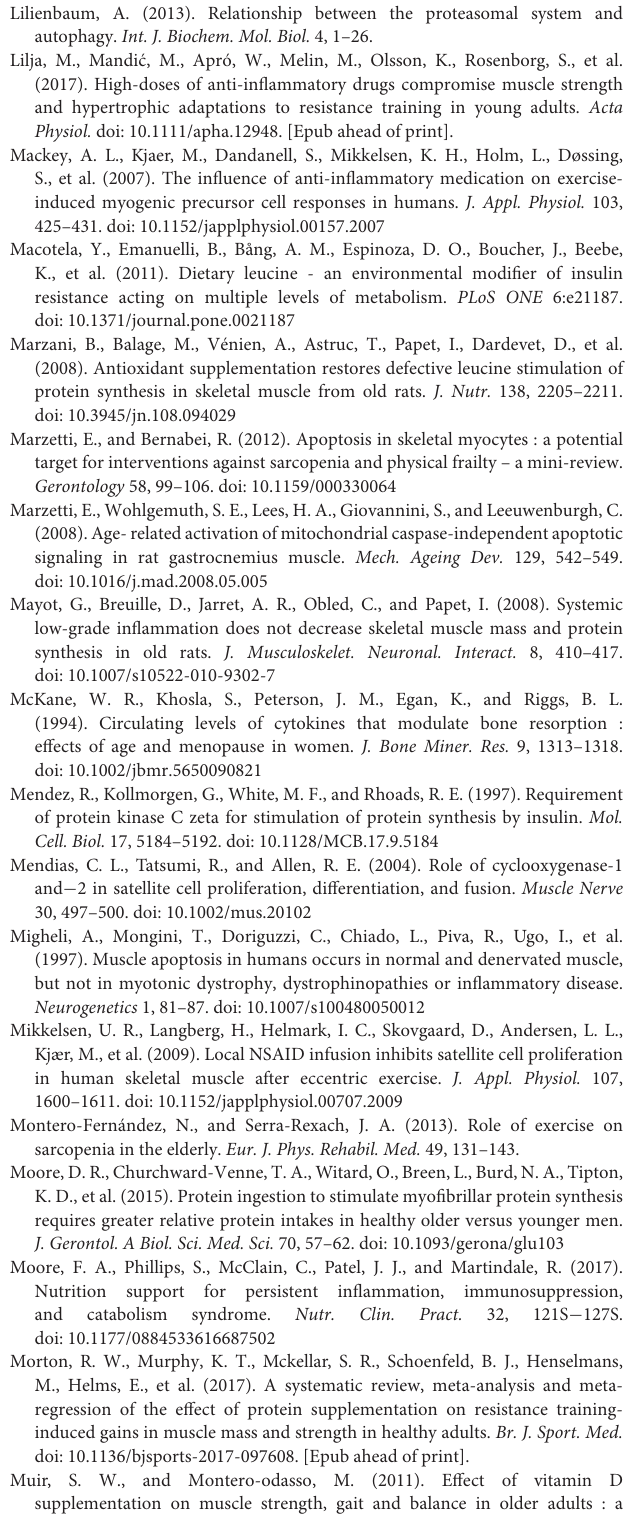
supplementation on muscle strength, gait and balance in older adults : a